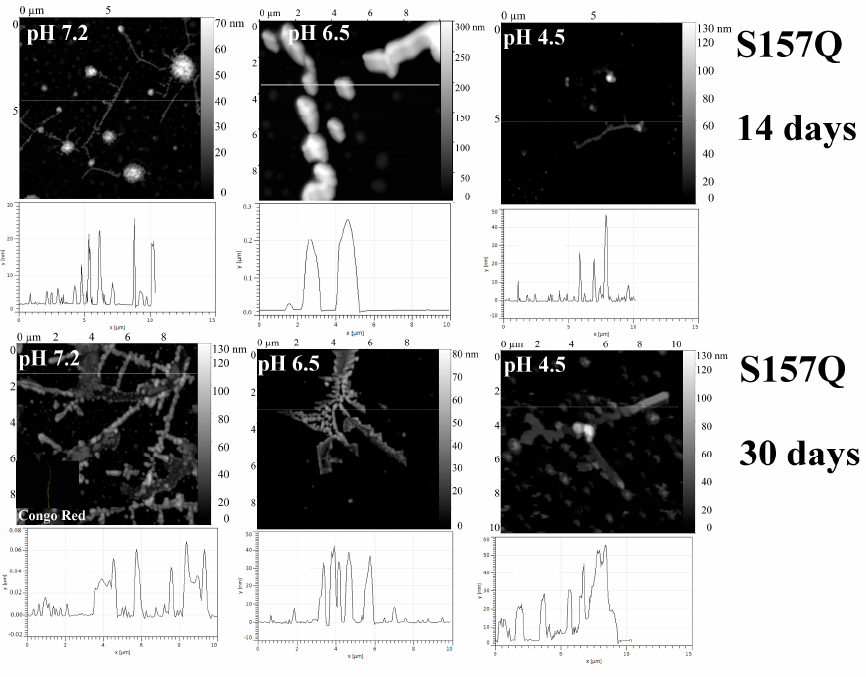
Figure 10. The morphology of S157Q aggregates at pH 7.2, 6.5 and 4.5 after 14 days and 30 days of incubation at 37 °C (AFM images obtained in tapping mode). Congo Red birefringence is shown.